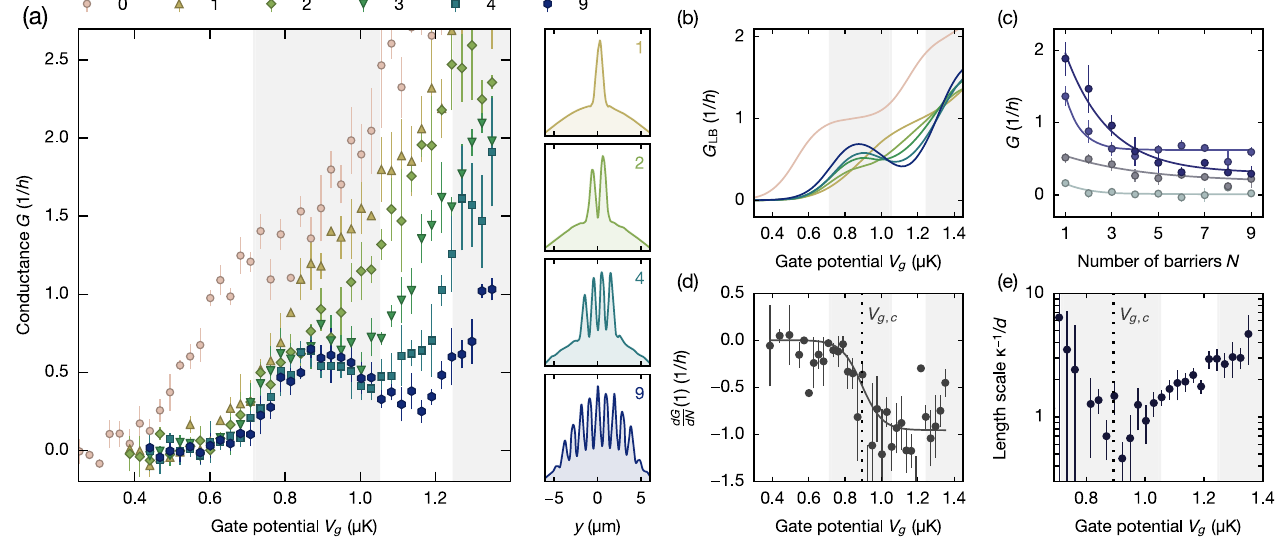
FIG. 2. Building up a lattice site by site. (a) Conductance G as a function of attractive gate potential V with one barrier, and with a lattice of 2 – 9 barriers. The potential height of the central barrier is set to V where E is the lattice recoil energy. The first and second bands of an infinite lattice of the same height are indicated by gray areas, r separated by a gap which coincides with the location of the conductance minimum for 9 barriers. Right-hand panels: Actual quasi-one- dimensional potentials for 1, 2, 4, and 9 barriers. (b) Conductance G temperature T ¼ 67 nK and a typical chemical potential difference Δ μ ¼ 0 . 1 μ K between the reservoirs. (c) Conductance G as a function of number of barriers N for four gate potentials V